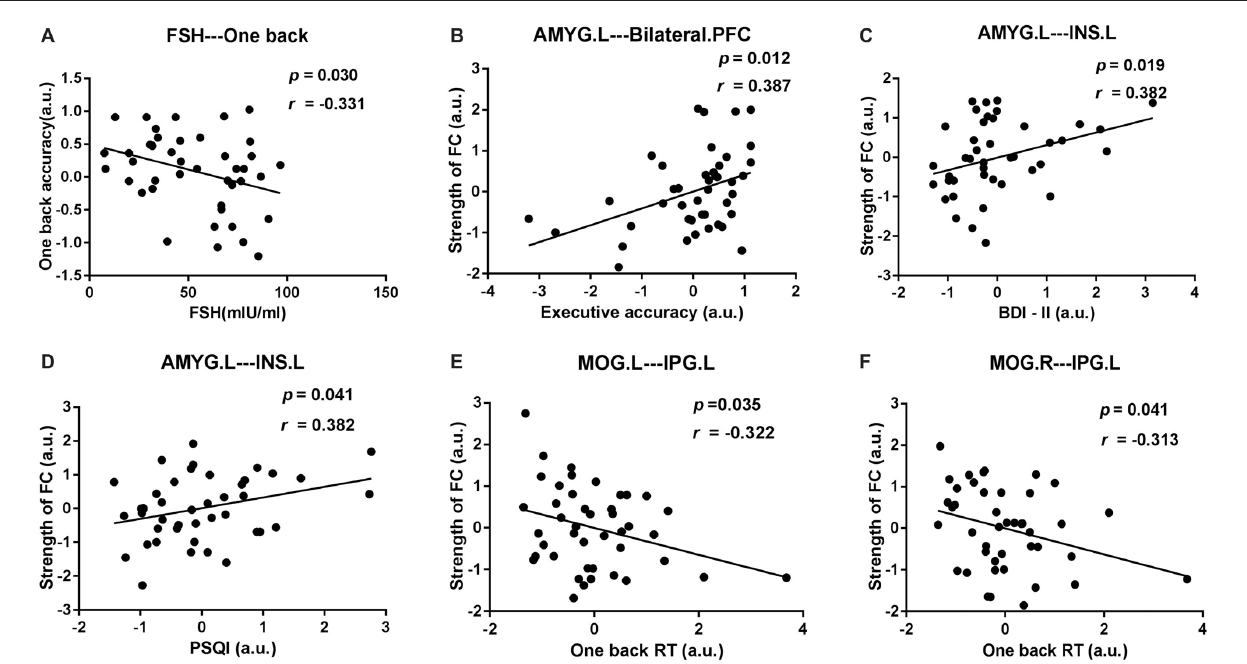
FIGURE 5 | Scatter diagrams showing the significant pair-wise correlations between abnormal DC, rsFC, clinical and neuropsychological data in early postmenopausal women in (A–F) . (A) The serum follicle-stimulating hormone (FSH) level was negatively correlated with the working memory accuracy rate. (B) The executive function accuracy rate was positively correlated with the increased FC strength between the AMYG.L and bilateral prefrontal cortex (PFC). (C,D) The increased FC strength between the AMYG.L and left insula (INS.L) was simultaneously positively correlated with the BDI-II and pittsburgh sleep quality index (PSQI) score. (E) The working memory reaction time (RT) was negatively correlated with the decreased FC strength between the MOG.L and left inferior parietal gyrus (IPG.L.) (F) The working memory RT was negatively correlated with the decreased FC strength between the MOG.R and IPG.L.